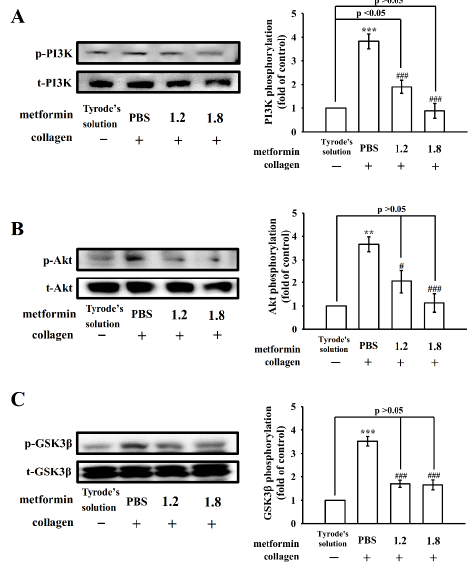
Figure 5. Regulatory effect of metformin in phosphoinositide 3-kinase/Akt/glycogen synthase kinase-3 β . Washed platelets were preincubated with PBS or metformin (1.2 and 1.8 mM) and treated with collagen (1 µ g/mL) for immunoblotting of ( A ) phosphoinositide 3-kinase (PI3K), ( B ) Akt, and ( C ) glycogen synthase kinase-3 β (GSK3 β ) phosphorylation. Results are expressed as mean ± standard error of the mean ( n = 4). ** p < 0.01 and *** p < 0.001 vs. Tyrode’s solution; # p < 0.05 and ### p < 0.001 vs. PBS + collagen group. Appl. Sci. 2022 , 12 , x FOR PEER REVIEW